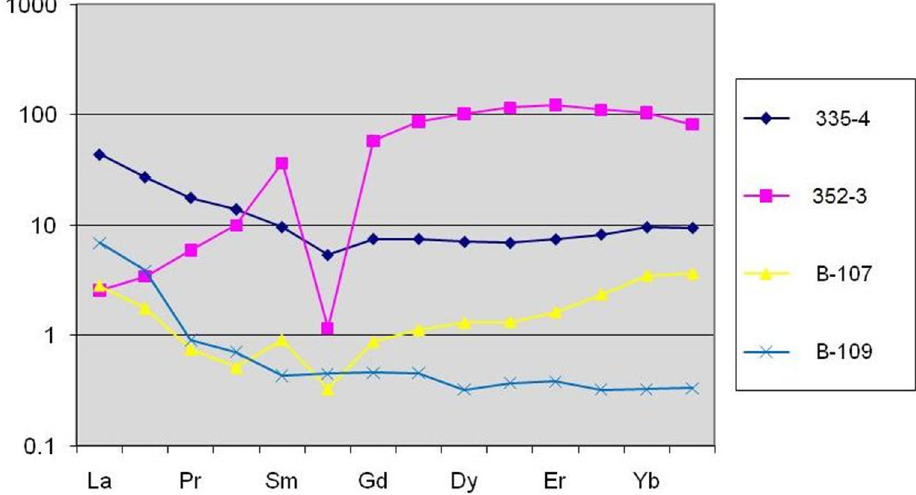
Figure 10. Chondrite normalized [31] REE patterns of the fluorites in the Voznesenskoe deposit.